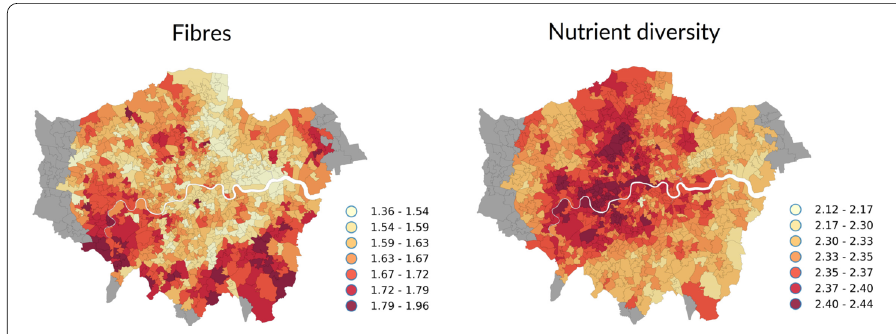
Figure 5 London maps reflecting the fraction of an area’s total calories coming from fibres as per Formula (6) (left), and nutrient diversity as per Formula (5)